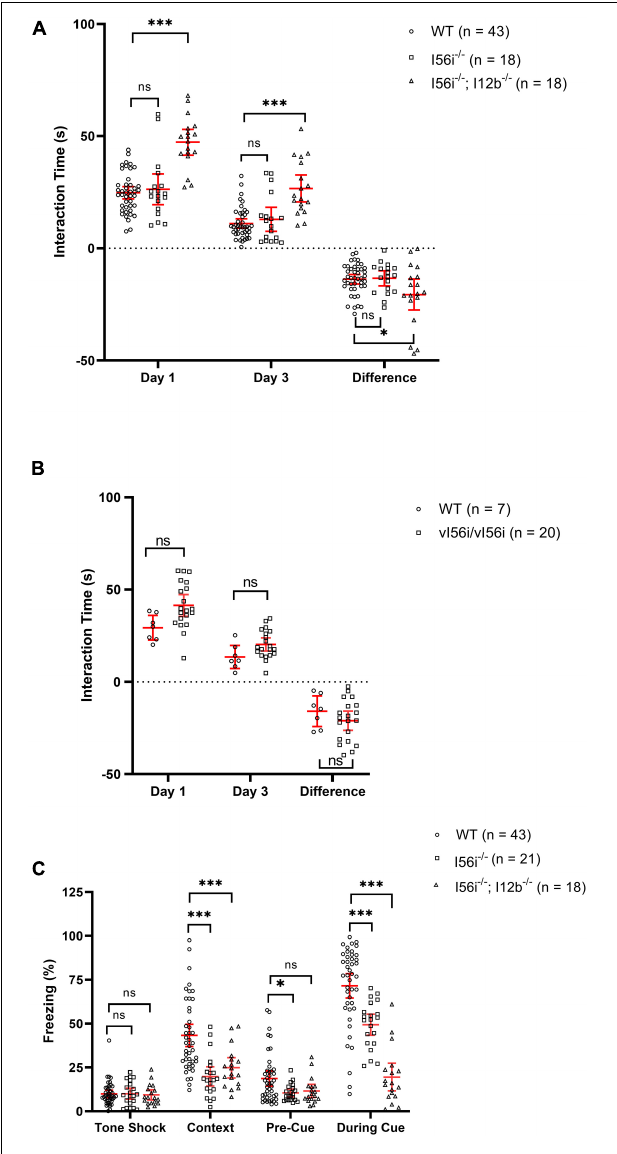
FIGURE 6 | Mice with deletions of Dlx enhancers show an increased propensity for sociability and memory/learning defects. (A) Social interaction test performed on WT (black), homozygous I56i ( − / − ) (white) and homozygous I56i ( − / − ) – I12b ( − / − ) (stripes). (B) Social interaction test preformed on WT (black) and homozygous vI56i (white). (C) Fear conditioning test preformed on WT (black) homozygous I56i ( − / − ) (white) and homozygous I56i ( − / − ) – I12b ( − / − ) (stripes). Numbers of mice listed in the brackets of each graph. Data shown as mean, error bars represent SEM. Data was analyzed using one-way ANOVA with Turkey’s multiple comparison test (* p < 0.05, *** p <